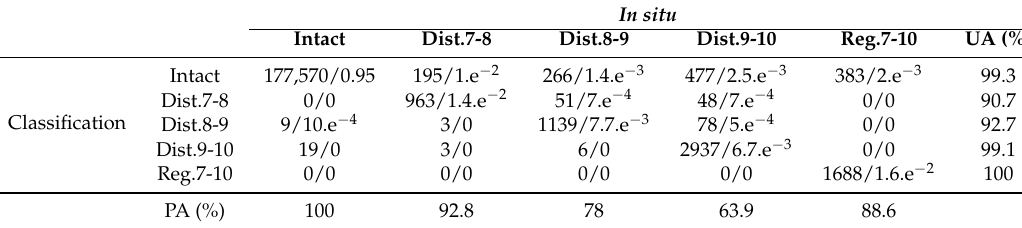
Table 4. Validation of the forest disturbance and regrowth detection method. In the error matrix of sample counts n ij and of estimated area proportions ˜ p ij [51] (shown as n ij / ˜ p ij in the error matrix), rows show the intact forest (Intact), the annual forest disturbances between 2007 and 2008 (Dist.7-8), 2008 and 2009 (Dist.8-9) and 2009 and 2010 (Dist.9-10) and the forest regrowth between 2007 and 2010 (Reg.7-10), as determined by the detection method. Columns indicate the reference polygons from the database derived as explained in Section 2.2. The validation samples represent 90% of the database described in Section 2.3. Based on estimated area proportions, the mean PA was 84.7%, and the mean UA was